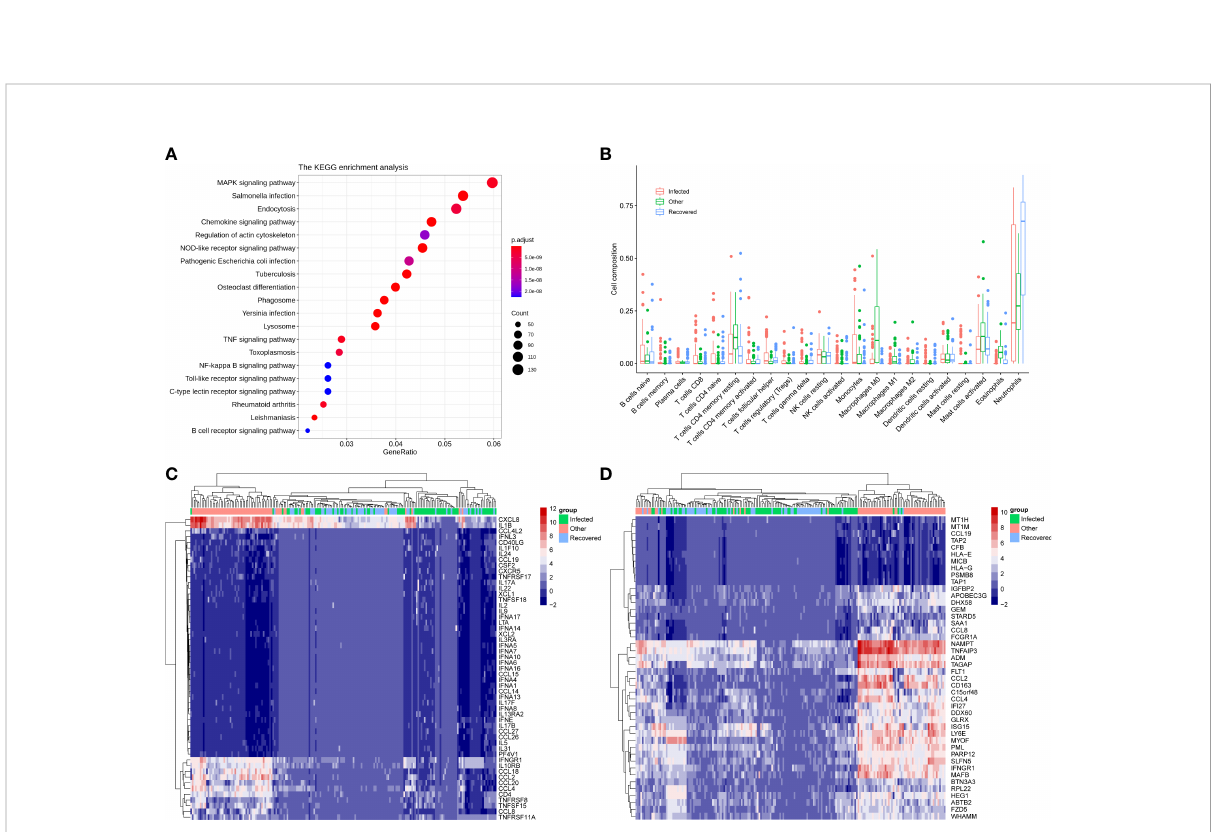
FIGURE 2 Immune signatures associated with differentially expressed genes. (A) KEGG enrichment analysis of the differential expressed genes between infected and other groups. (B) Cell composition was estimated by the CIBERSORT algorithm of samples for infected, other, and recovered groups. (C) Heatmap showing the expression pattern of 53 differential immune genes across groups. (D) Heatmap showing the expression pattern of 44 differential interferon-stimulated genes (ISG) across groups.